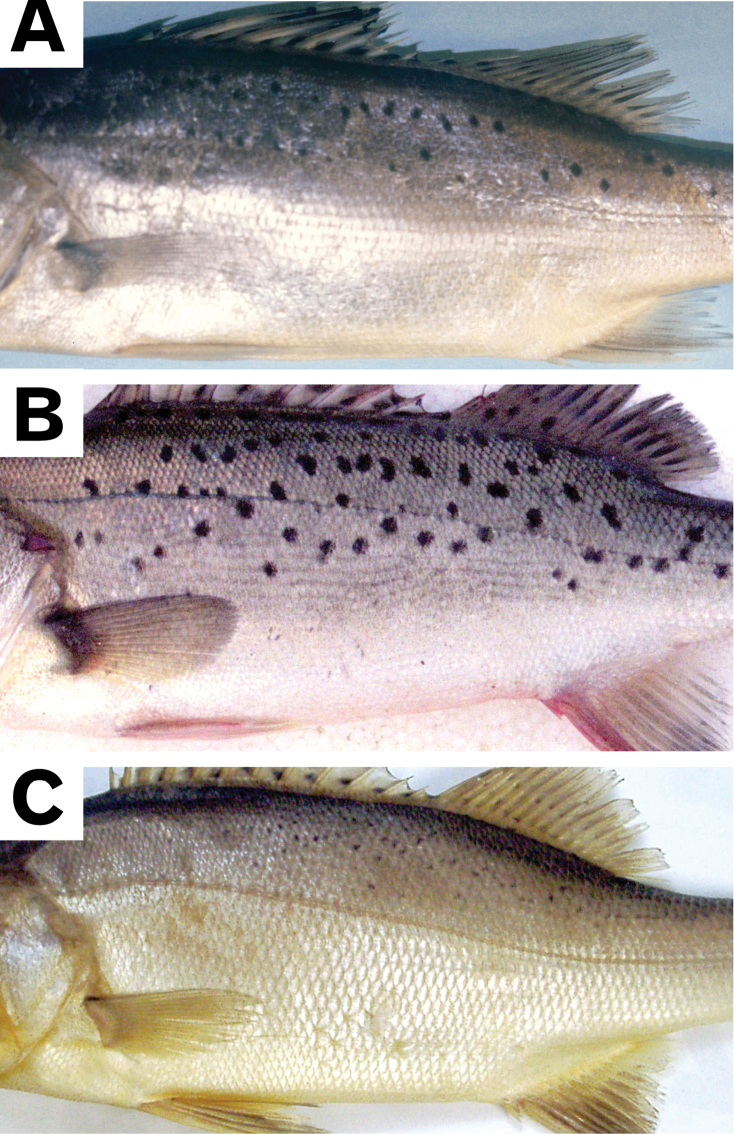
Dots / spots on lateral body regions of Lateolabraxjaponicus (A), L.maculatus (B) and L.latus (C). A uncatalogued specimen (168.4 mm SL) BBSKU 100773 (254.2 mm SL) CKAUM–I. 29117 (219.7 mm SL).